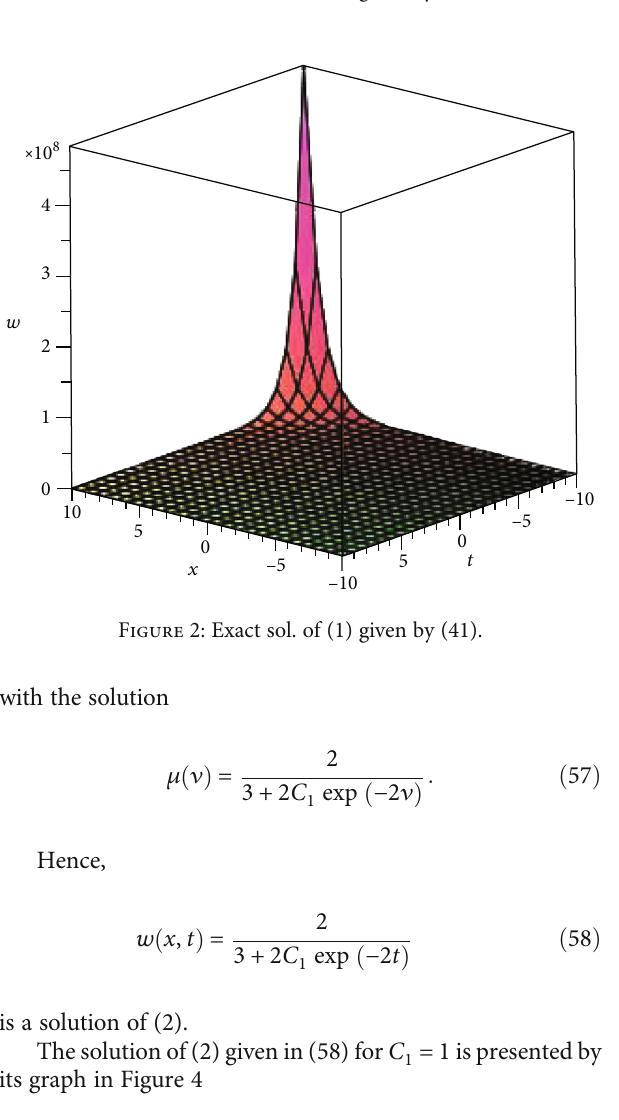
Figure 1: Exact sol. of (1) given by (23).